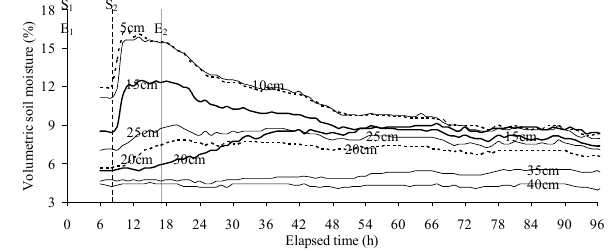
Fig. 6. The wetting front advance from 14:00 LT of 28 August to 14:00 LT of 1 September. Vertical lines of paired S and E represent the start (dashed line) and end (solid line) of individual rainfall, respectively.